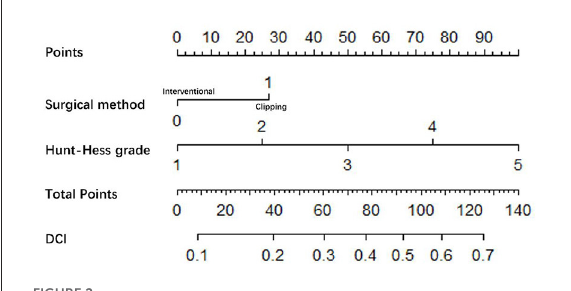
FIGURE2 Nomogram (Based on DCI group, non-DCI